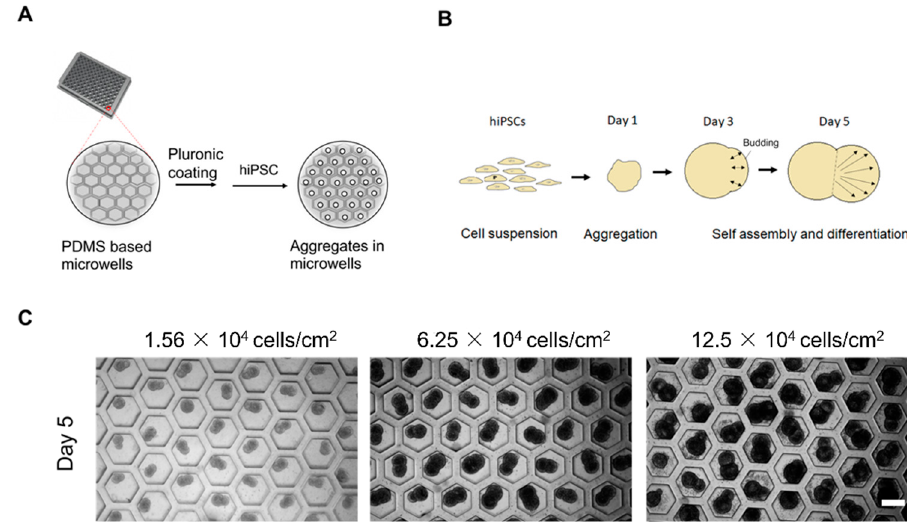
Figure 1. Experimental setup, cell seeding, and mechanism. ( A ) Schematic concept of the prepara- tion of microwells prior to cell seeding. ( B ) Schematic illustration of the self-assembled aggregates. ( C ) Aggregates after Day 5 versus cell seeding density, scale bar: 200 µm, N = 3 sets of independent experiments.